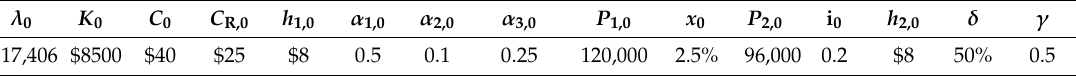
Table 1. The assumed parameters’ values in stage